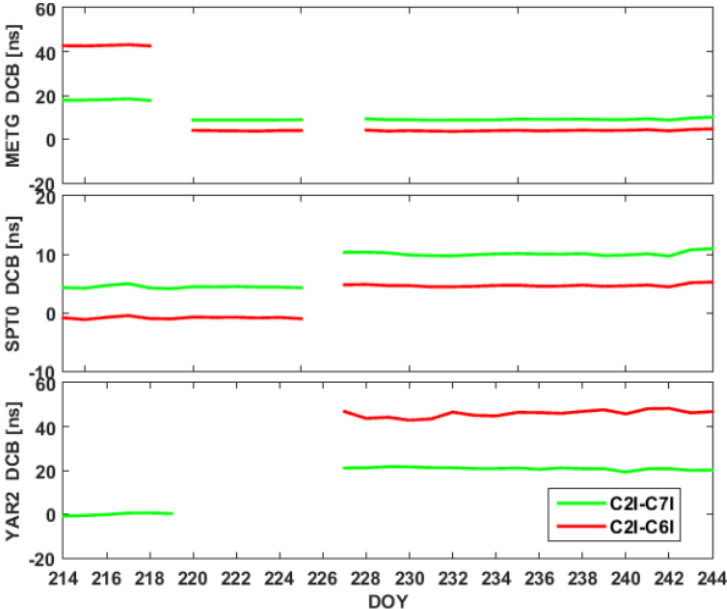
Figure 17. Time series of daily DCB estimates at stations METG, SPT0 and YAR2 for DOY 214 to 244, 2020.